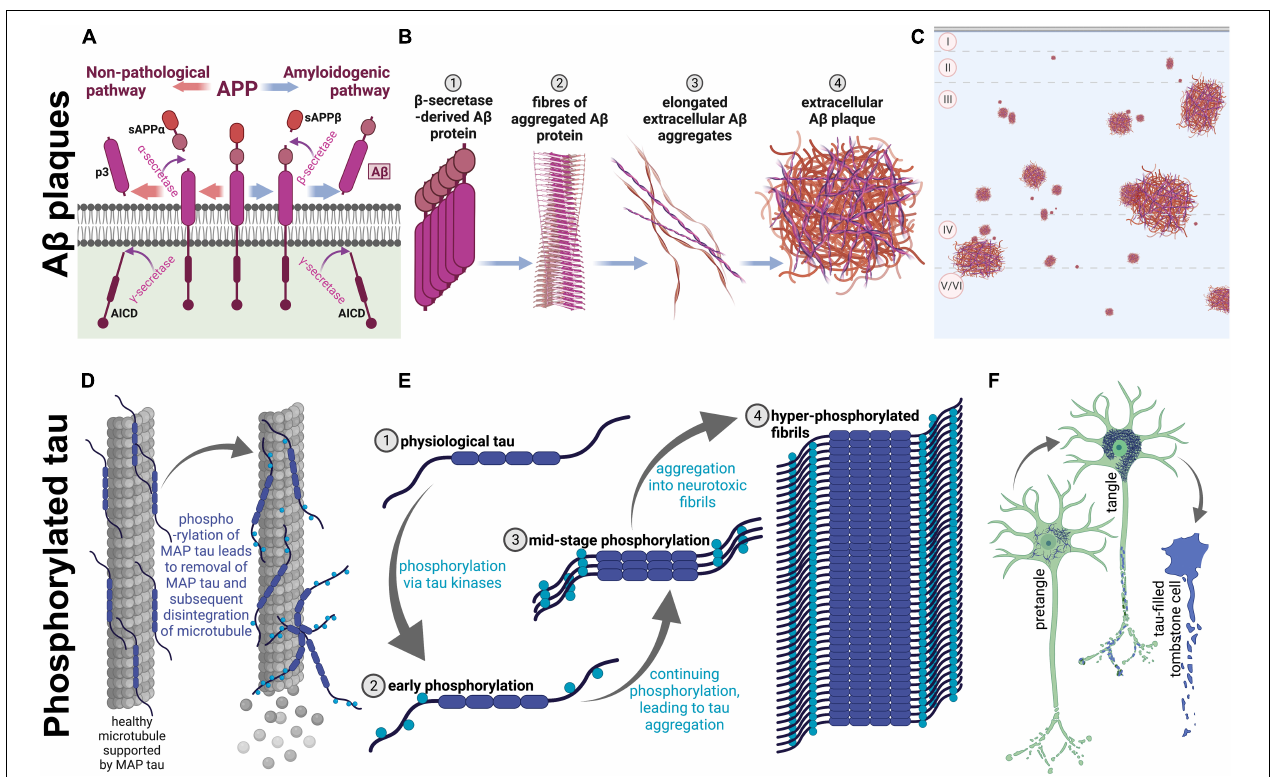
FIGURE 1 | Amyloidogenesis and tau tangle formation across aging. Physiological proteins amyloid precursor protein (APP) and microtubule-associated protein tau undergo modifications during aging to form plaques and tangles, respectively. These processes occur in both humans and rhesus macaques across aging, resulting in parallel pathological aggregations of the same proteins in both species. (A–C) Show amyloidogenesis, while (D–F) represent processes involved in tau pathology. (A) Prior to aging, the transmembrane amyloid precursor protein is cleaved by α -secretase to form soluble amyloid precursor protein α (sAPP α ; orange arrows; left), and subsequently cleaved further by γ -secretase, which creates p3 and APP intracellular domain (AICD). On the other hand, when APP is cleaved by β -secretase (blue arrows; right), soluble APP β (sAPP β ) is formed before γ -secretase cleavage into AICD and A β , an insoluble pathological protein which is cleaved into the extracellular space. sAPP α , sAPP β , and p3 are non-pathological APP fragments released extracellularly, while AICD is also physiologically relevant and is released into the intracellular matrix. (B) A β proteins begin to aggregate (1), create fibrils (2), form elongated fibers (3), and finally these fibers aggregate into insoluble extracellular plaques in the cortex (4). (C) A graphical representation of extracellular A β plaques in the neocortex. The top of the image represents the pial surface, with dashed horizontal lines signifying boundaries between cortical layers. Plaques vary in size and can be present in cortical layers II-VI. (D) On the left, microtubule-associated protein tau (tau) supports microtubules, a part of the neuronal cytoskeleton. When tau begins to be phosphorylated (on the right), the protein no longer adheres to the microtubule, leading to disintegration of the microtubule and subsequent degeneration of the neurites. (E) Tau (1) phosphorylation begins with early phosphorylation sites, which remove the protein from its role providing support to microtubules (2). These phosphorylated proteins are therefore present in the intracellular space, and free to be further phosphorylated by various tau kinases, which leads to intracellular aggregation (3). Eventually, hyperphosphorylation leads to formation of tau fibrils (4), which aggregate intracellularly. (F) Graphical representation of the clinical progression of intracellular tauopathy. In all three neurons, blue represents phosphorylated tau (p-tau). First, p-tau accumulates in the cell, visible via cytoplasmic immunoreactivity, and can be considered a pretangle. It can be presumed that early axonal degeneration is occurring, due to accumulation of detached tau in the cytoplasm. Then, when tauopathy progresses, the cytoplasm shows heavy, fibrillous tau aggregations, which exclude the nucleus and usually present as a teardrop-like shape as seen in the middle neuron. Additionally, at this stage, dystrophic neurites are visibly tau-filled (represented by blue axonal inclusions) and the neuron is presumed to be primarily non-functional. Finally, p-tau continues to fill the intracellular space until the neuron dies. At this stage, the nucleus is no longer distinguishable, and the cell membrane may be “leaking” tau into the extracellular space. The first two phenotypes are seen in very old monkeys, but progression to tombstone cells is uncommon. Figure created with